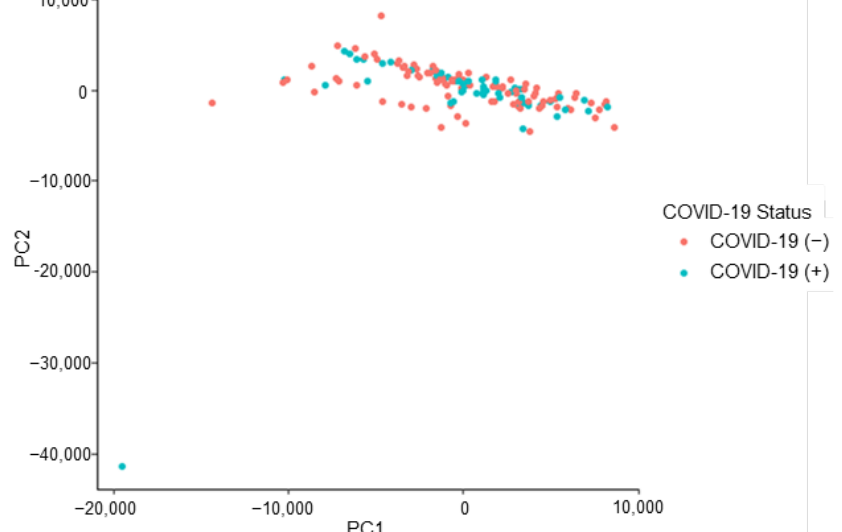
Figure 4. COVID T-shirt PCA: subgrouping removed, labelled by donor’s COVID-19 status. Model